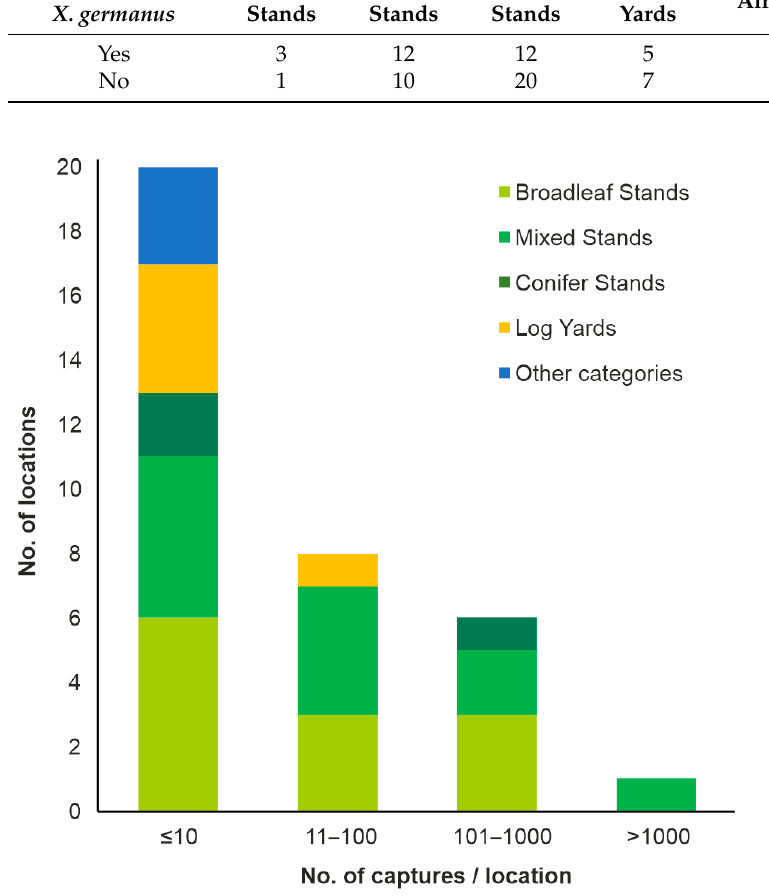
Figure 6. Number of locations and habitats with different BSB capture sizes.